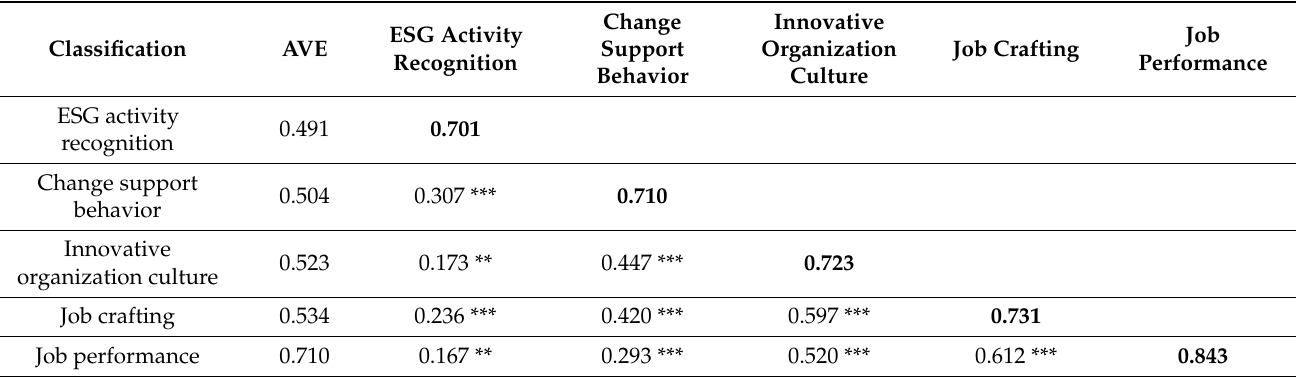
Table 5. Discriminant